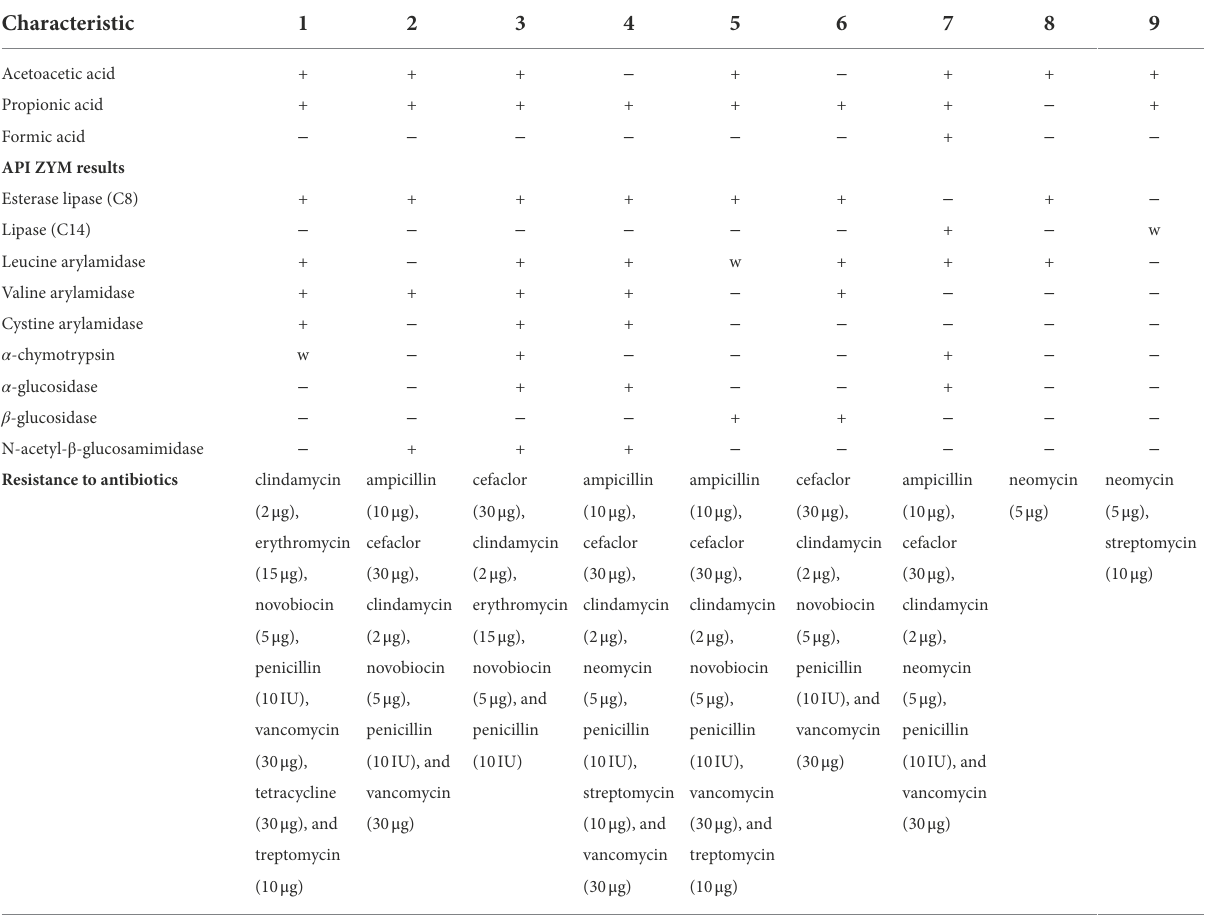
(Supplementary Figure S3), which slightly contrasted with the 16S rRNA gene-based phylogenetic tree, although the genome comparisons were concordant with comparisons of the 16S